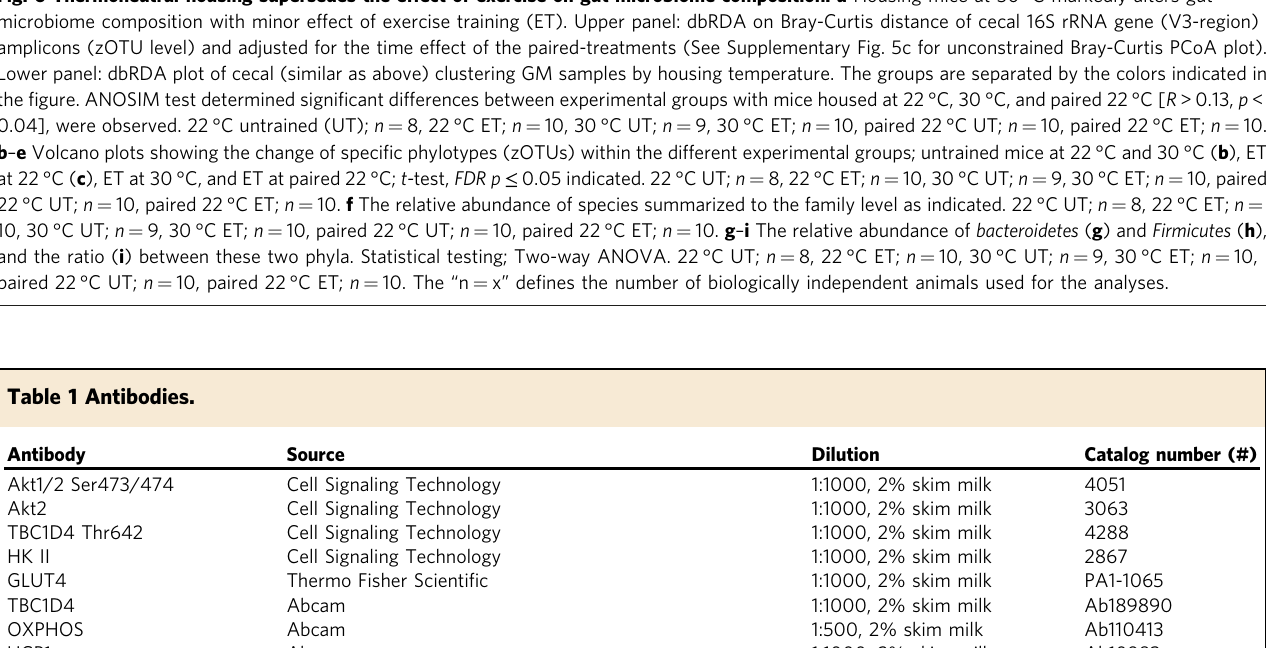
Body composition . Total, fat and lean body mass were measured weekly by nuclear magnetic resonance using an EchoMRI ™ (USA). Metabolic chambers . After a 3-day acclimation period in the metabolic cages, oxygen consumption, ambulant activity (beam breaks), food intake and running distance/speed were measured by indirect calorimetry in a CaloSys apparatus during at least 2 days (TSE Systems, Bad Homburg, Germany). To test the acute effects of thermoneutrality, a group of mice were housed in the metabolic chambers at 22°C for 3 days followed by an increase in the temperature to 30 °C for 3 days. All mice were single-housed during housing in metabolic cages.